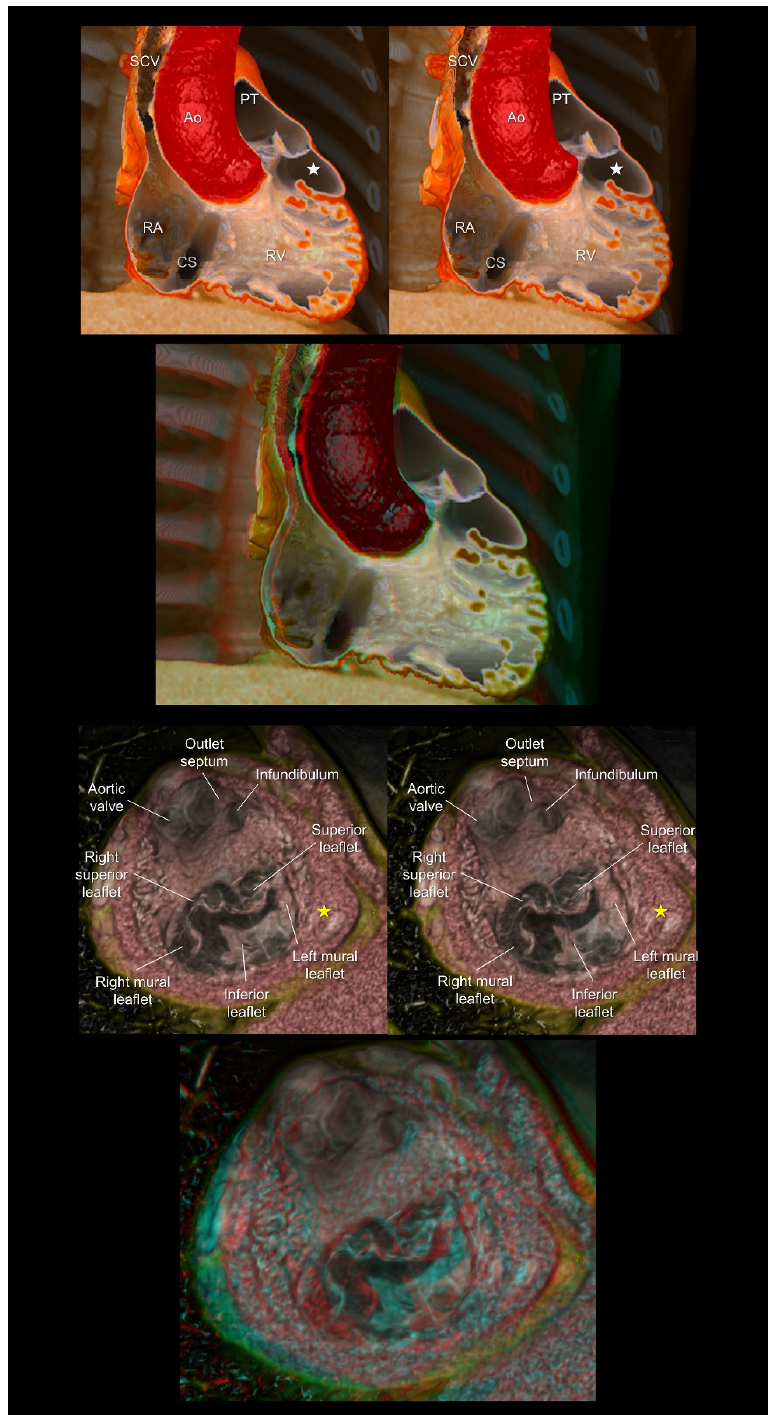
Figure 8. The upper panels show the double ‐ chambered right ventricle with abnormally developed septoparietal trabeculations creating a low ‐ pressure outflow chamber (white stars) beneath the pulmonary valve. The lower panels show a complex cardiac malformation case with right isomerism, a common atrioventricular junction, an atrioventricular septal defect, the double ‐ outlet right ventricles, and subpulmonary infundibular stenosis. The yellow stars indicate a solidified rudimentary chamber. The first and second panels are aligned for cross ‐ eyed viewing. The third panel is the anaglyph. To see the anaglyph, anaglyphic glasses (red/cyan) are required. Ao, aorta; CS, coronary sinus; PT, pulmonary trunk; RA, right atrium; RV, right ventricle; SCV, superior caval vein.